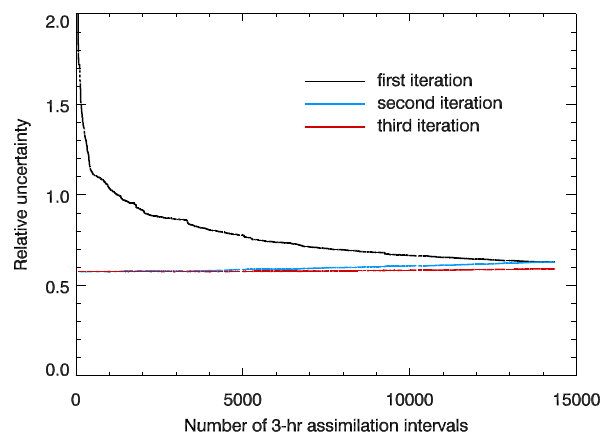
Fig. 8. Evolution of the grid average relative uncertainty of HFC- 125 emissions for the reference simulation during the three iteration steps. The average uncertainty is calculated as (cid:112) trace( P k ) / N e . The x-axis is the number of 3-hr assimilation intervals and covers thefullperiod2006-2010.